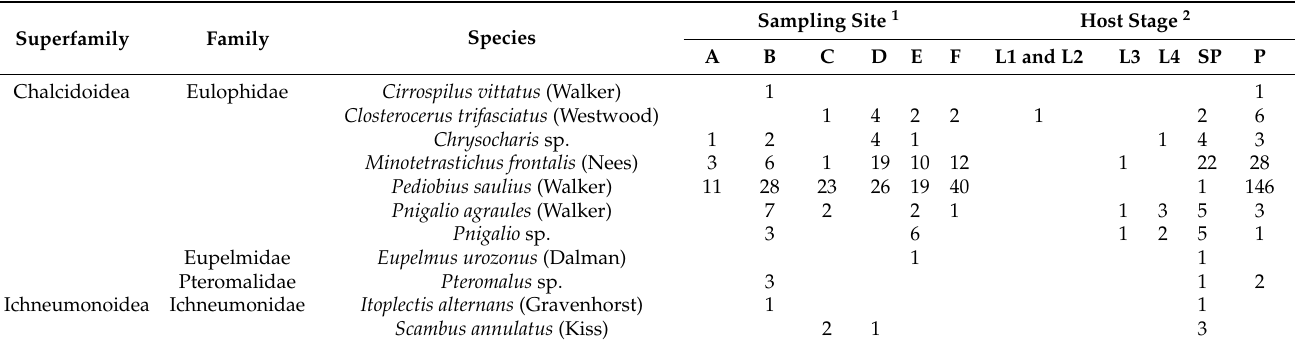
Table 3. Parasitoid species reared from C. ohridella and summary data regarding the sampling site and the developmental stage from 2006 to 2010.